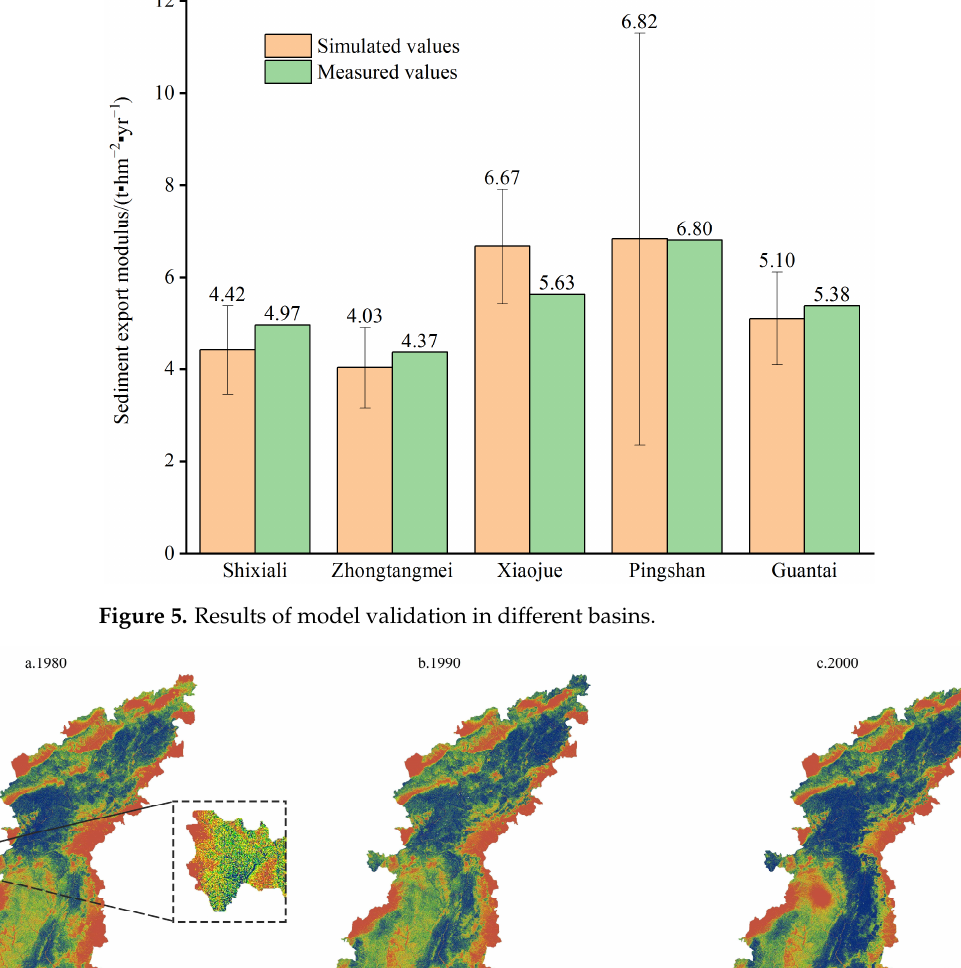
Figure 7. ( a ) Intensity of ecological engineering (IEE) and average SC from 1980 to 2020 in the Taihang Mountain area. ( b ) Differences in the average SC values in the different ecological engineering areas in 1980 and 2020. RFTF—returning farmland to forestland, RFTG—returning